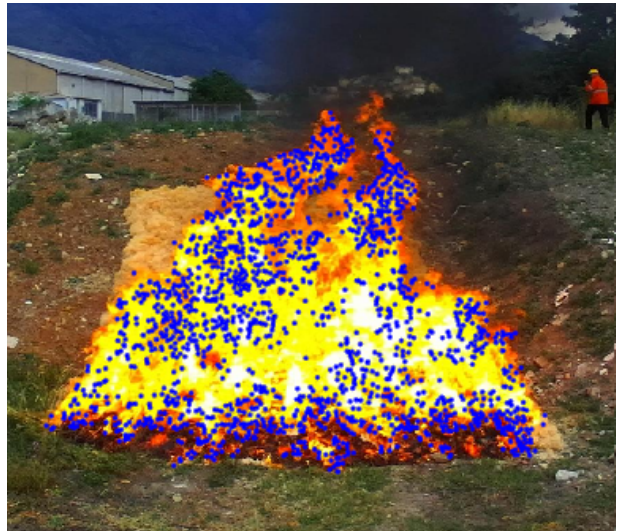
Figure 4. Matched points obtained from the features in Figure 3.